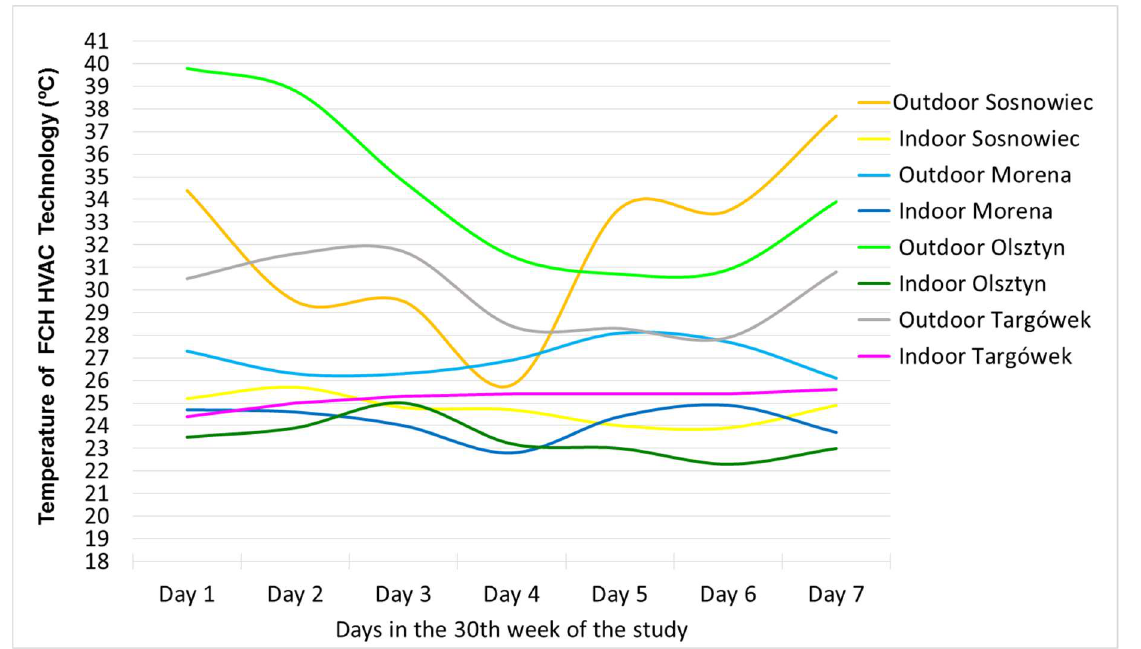
Figure 7. Example of outdoor and indoor parameters: summer, 25 July 2016–31 July 2016. Outdoor